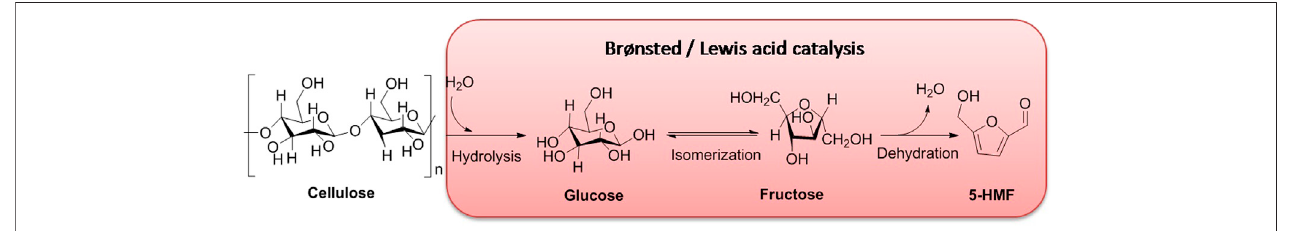
SCHEME 1 | Plausible pathway of 5-HMF converted from cellulose by solid